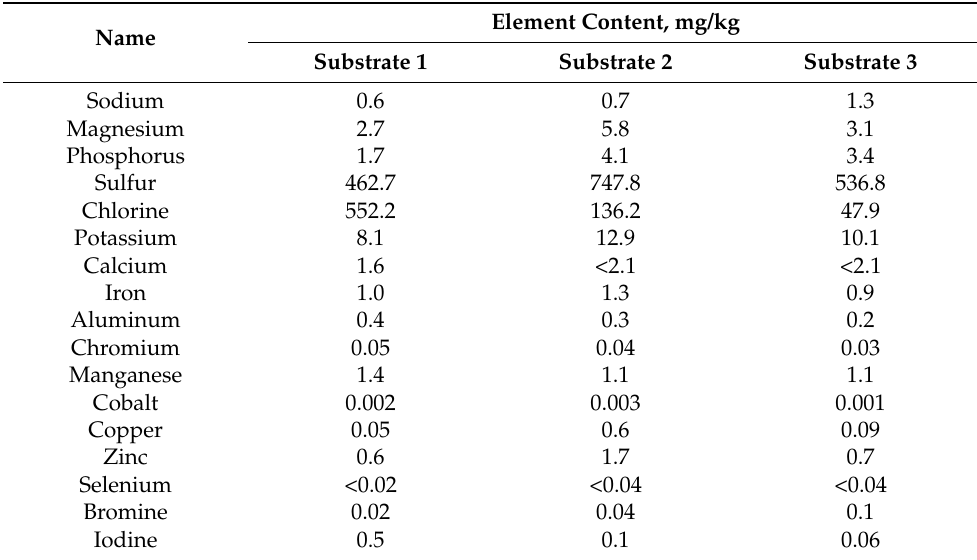
Table 4. Elemental composition of the substrate ashes after